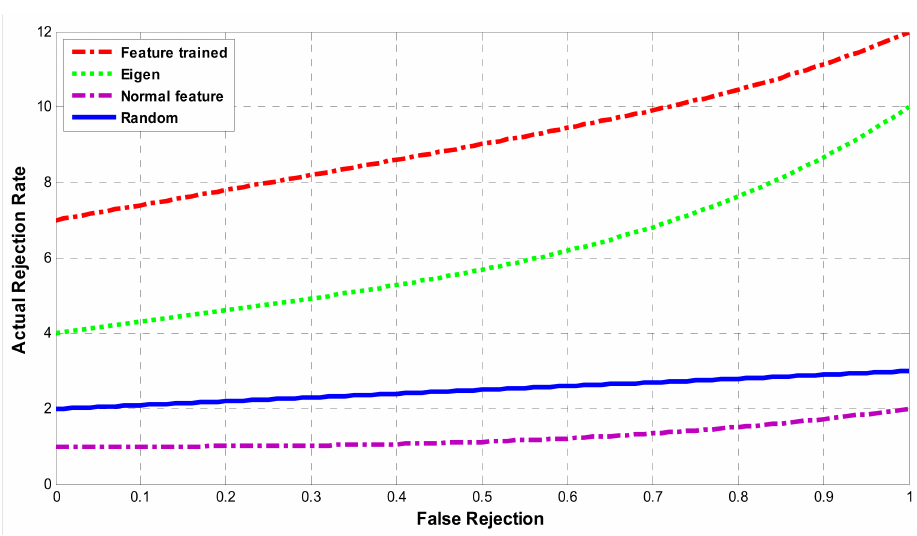
Figure 9. False rejection rate